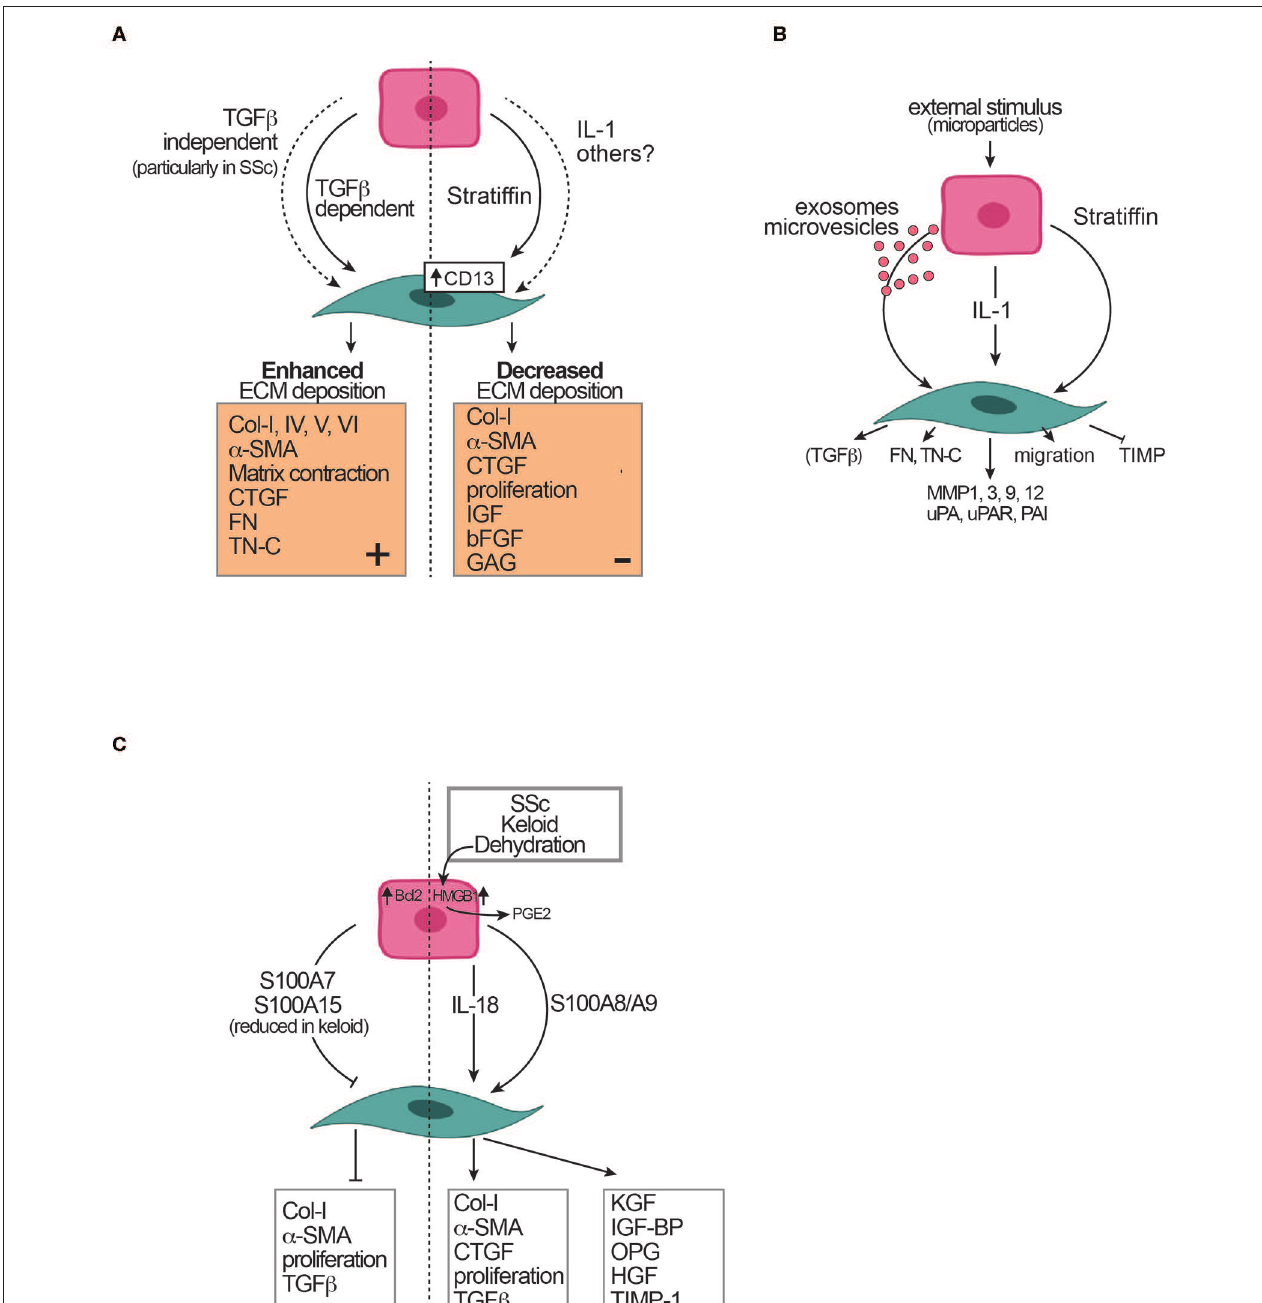
FIGURE 4 | Effects of keratinocytes on fibroblasts and extracellular matrix (ECM). (A) Controversial effects of keratinocytes on ECM deposition. (B) Mediators of keratinocyte effects on fibroblasts. (C) Skin pathological conditions and their effects on the crosstalk between keratinocytes and fibroblasts. The dotted vertical line separates controversial evidence. Arrowheads indicate enhancement. Blunted heads indicate inhibition. α SMA, alpha-smooth muscle actin; Bcl2, B-cell lymphoma 2; bFGF, basic fibroblast growth factor; Col, collagen; CTGF, connective tissue growth factor; FN, fibronectin; HGF, hepatocyte growth factor; HMGB1, high mobility group box-1; IGF, insulin-like growth factor; IGF-BP, insulin-like growth factor binding protein; KGF, keratinocyte growth factor; MMP, metalloproteinase; OPG, osteoprotegerin; OSM, oncostatin M; PAI, plasminogen activator inhibitor; PDGF, platelet-derived growth factor; PGE2, Prostaglandin E2; S100A7, psoriasin; S100A8/A9, calprotectin; S100A15,koebnerisin; SSc, Systemic sclerosis; SSc-F, SSc fibroblasts; SSc-K, SSc keratinocytes; TGF, Transforming growth factor; TIMP, tissue inhibitor of MMP; TN-C, tenascin C; TNF α , Tumor necrosis factor α ; uPA, urokinase-type plasminogen activator; uPAR, urokinase-type plasminogen activator